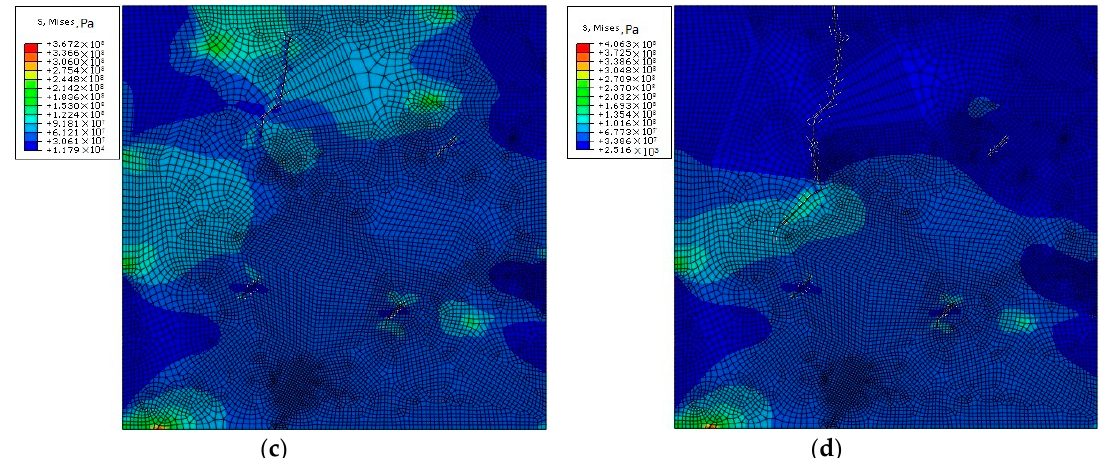
Figure 14. The ( a ) first stage, ( b ) second stage, ( c ) third stage, and ( d ) fourth stage of crack propagation with a load direction of 45°.